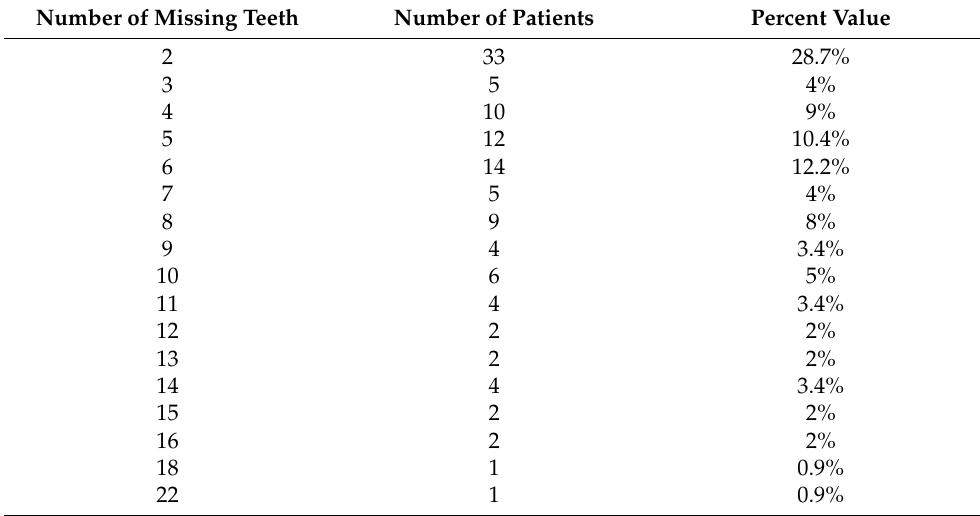
Table 3. Number of missing teeth in the study